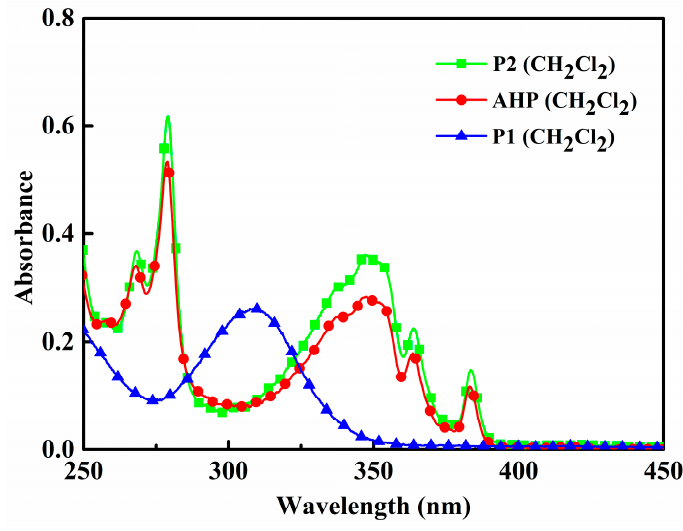
Figure 7. UV-VIS spectra of AHP, P1 , and P2 in CH 2 Cl 2 .